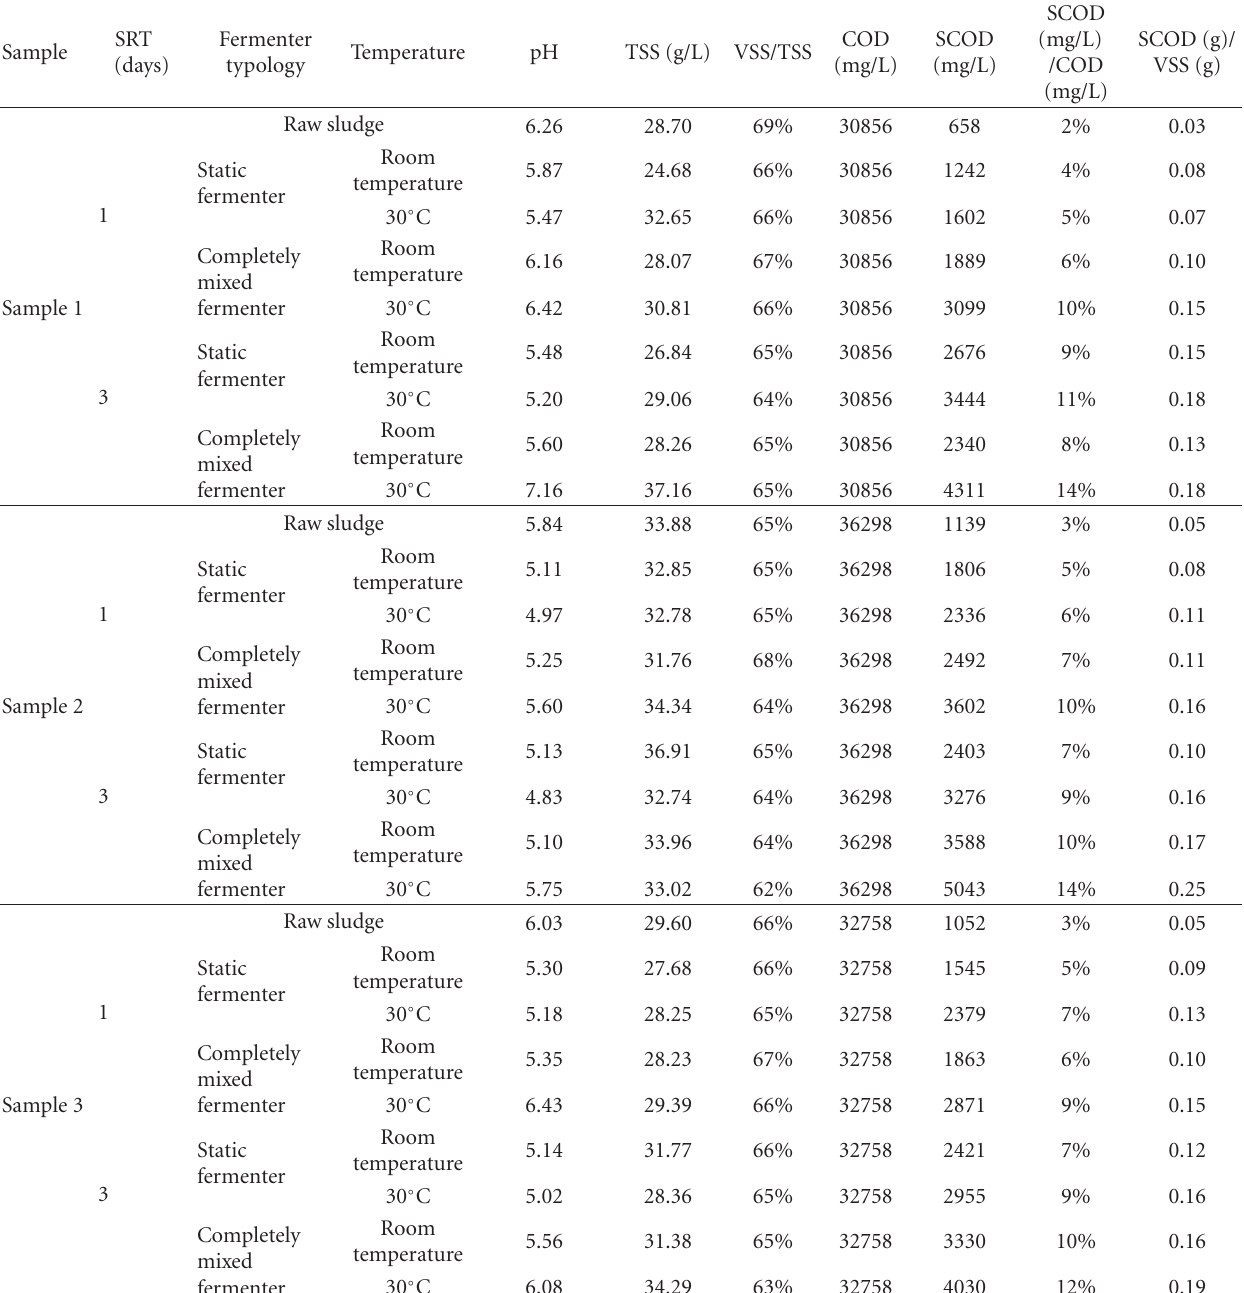
Table 2: Influence of temperature, agitation, sludge concentration, and SRT on PS from WWTP 1 fermentation: SCOD yield and specific SCOD